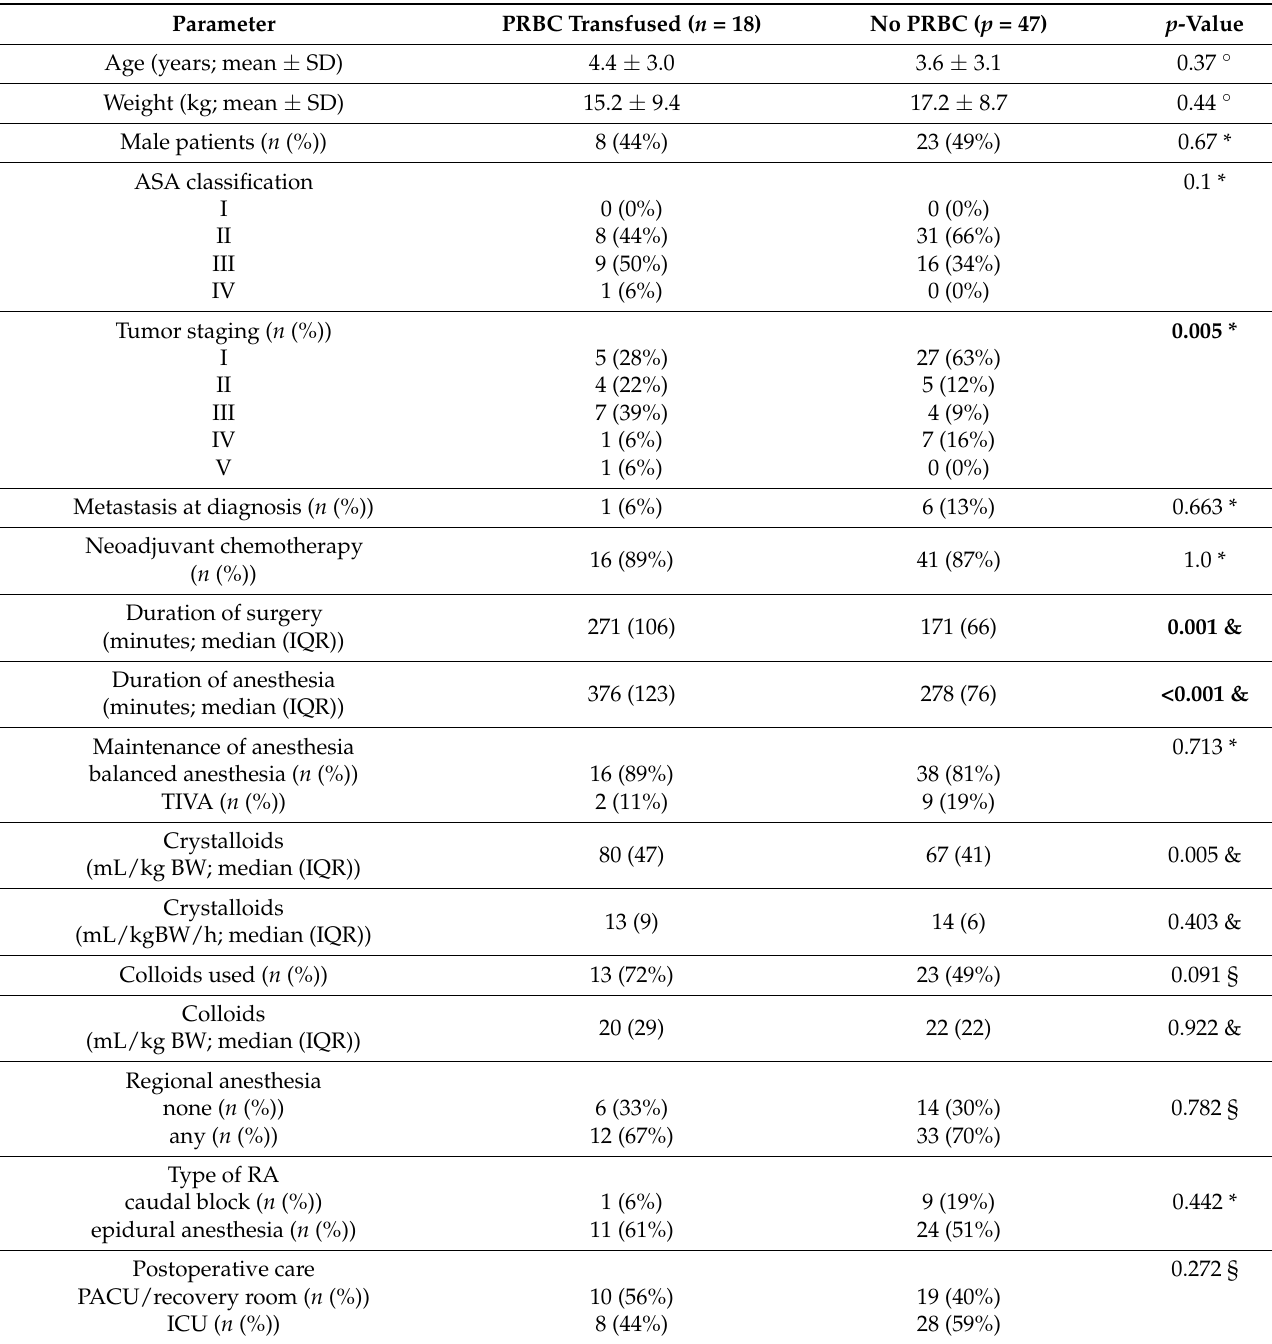
Table 2. Baseline patient characteristics and perioperative data: Intraoperative blood transfusion. PRBC = packed red blood cells, SD = standard deviation; ASA = American Society of Anesthesi- ology; IQR = interquartile range; TIVA = total intravenous anesthesia; RA = regional anesthesia, PACU = post-anesthesia care unit, ICU = intensive care unit; Statistical tests as indicated: * Fishers Exact test; ◦ Students’ t -test; & Mann-Whitney-U test; § Chi-square test. Statistically significant results are shown in bold